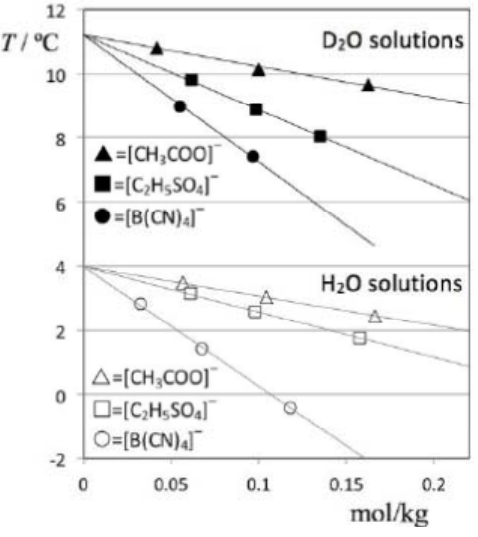
Figure 4. Temperatures of maximum density as a function of molal concentration for D O 2 O solutions (empty symbols) of three different ionic liquids: (filled symbols) and H 2 [C mim][CH COO] = (triangles); [C mim][C H SO ] = (squares); and [C mim][B(CN) ] = 2 3 2 2 5 4 2 4 (circles). The anomalous, “isotope-dependent” behavior of [C mim][C H SO ] solutions is 2 2 5 4 O- and H O-based apparent from the comparison of the D 2 2